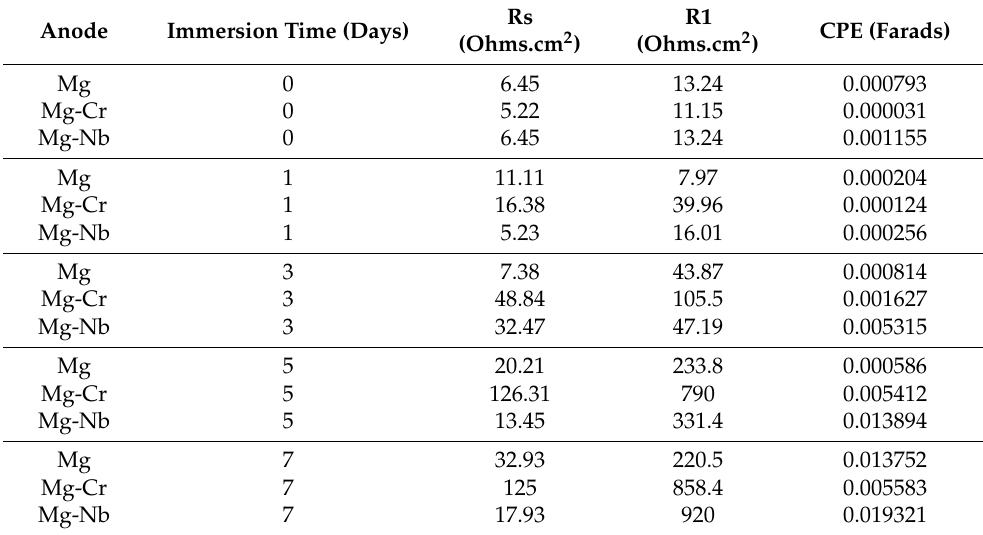
Table 2. Electrochemical parameters obtained from EIS